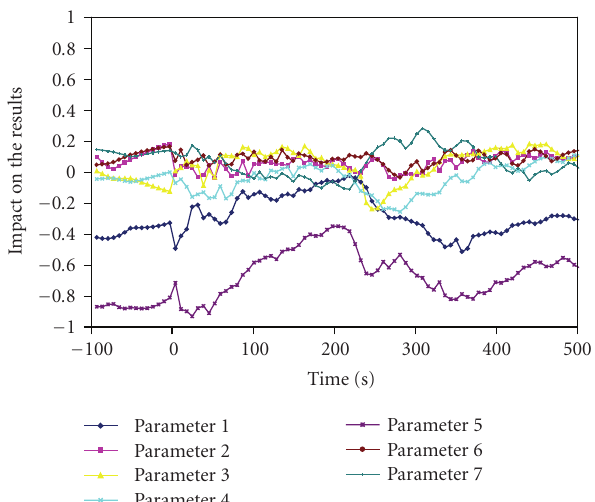
Figure 8: Loss-of-all-MCPs event. The impact of parameters no.1– 7 on the CHFR. The numbering of parameters is the same as in Table 1.